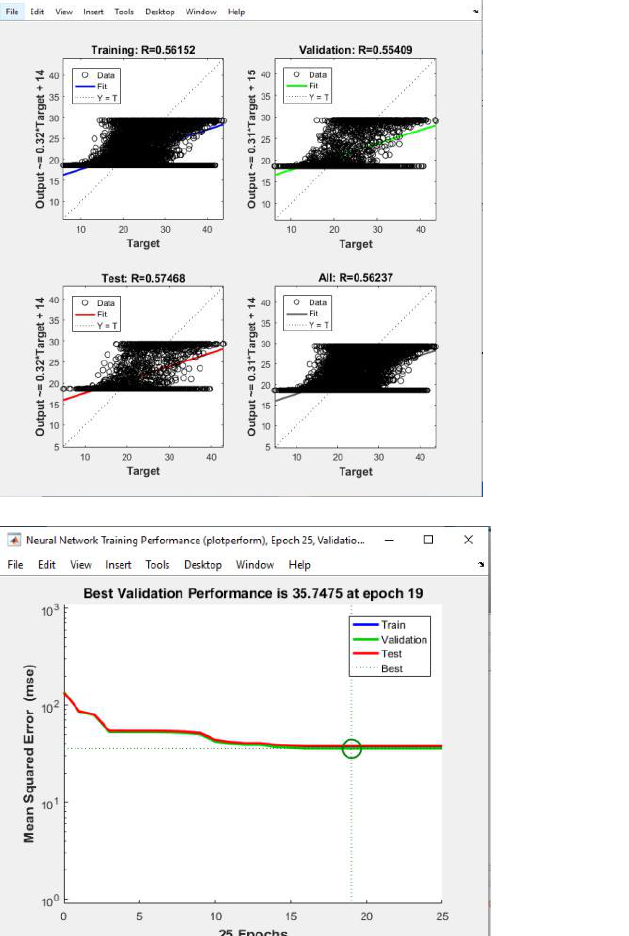
Figure 12 . As you can see in the performance plot, with the epochs the MSE (Mean Square Error) of the ANN has decreased.